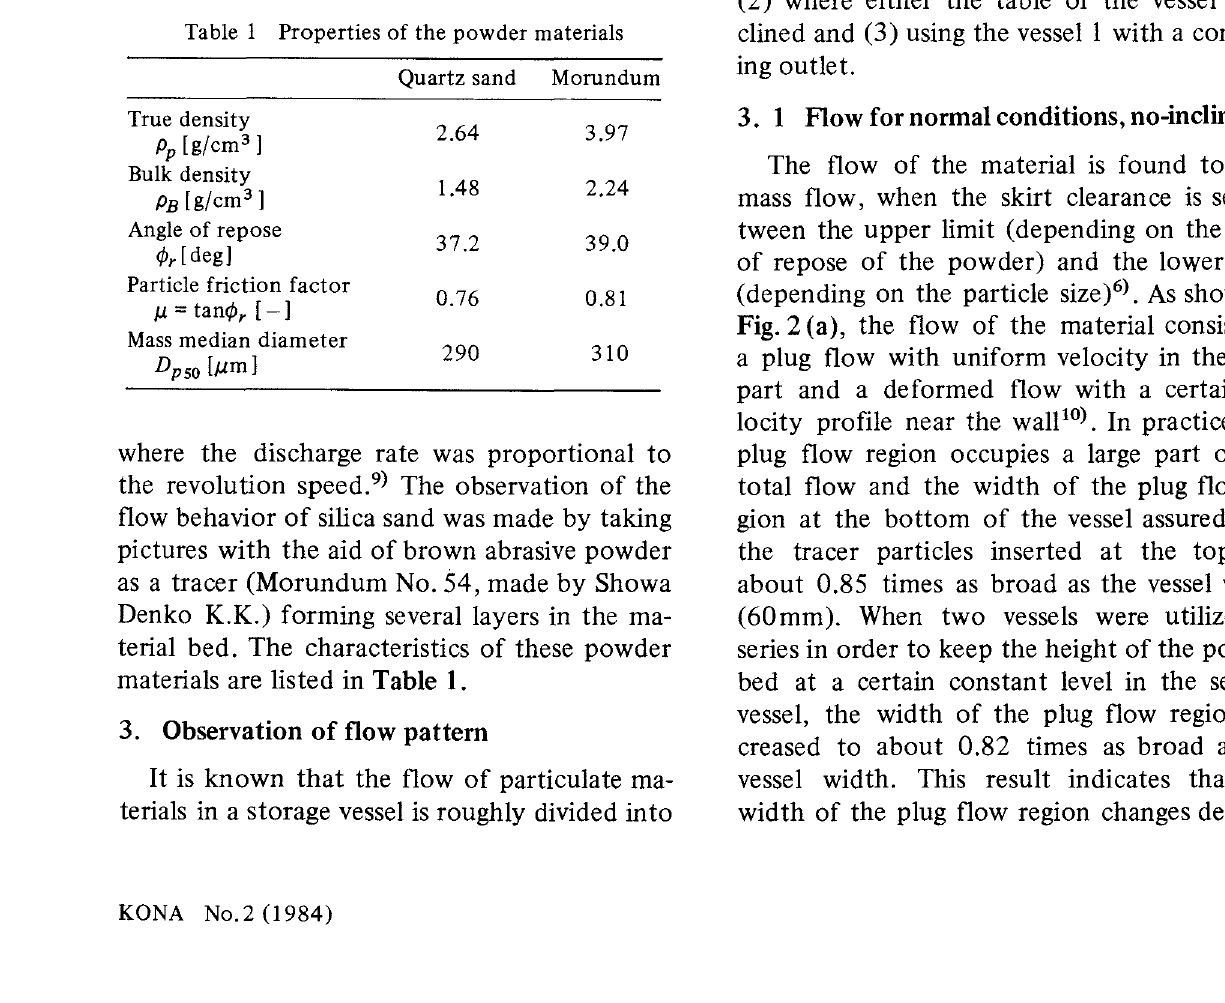
Fig. 2 Powder flow pattern in storage vessel (H = 8 mm, t = 5